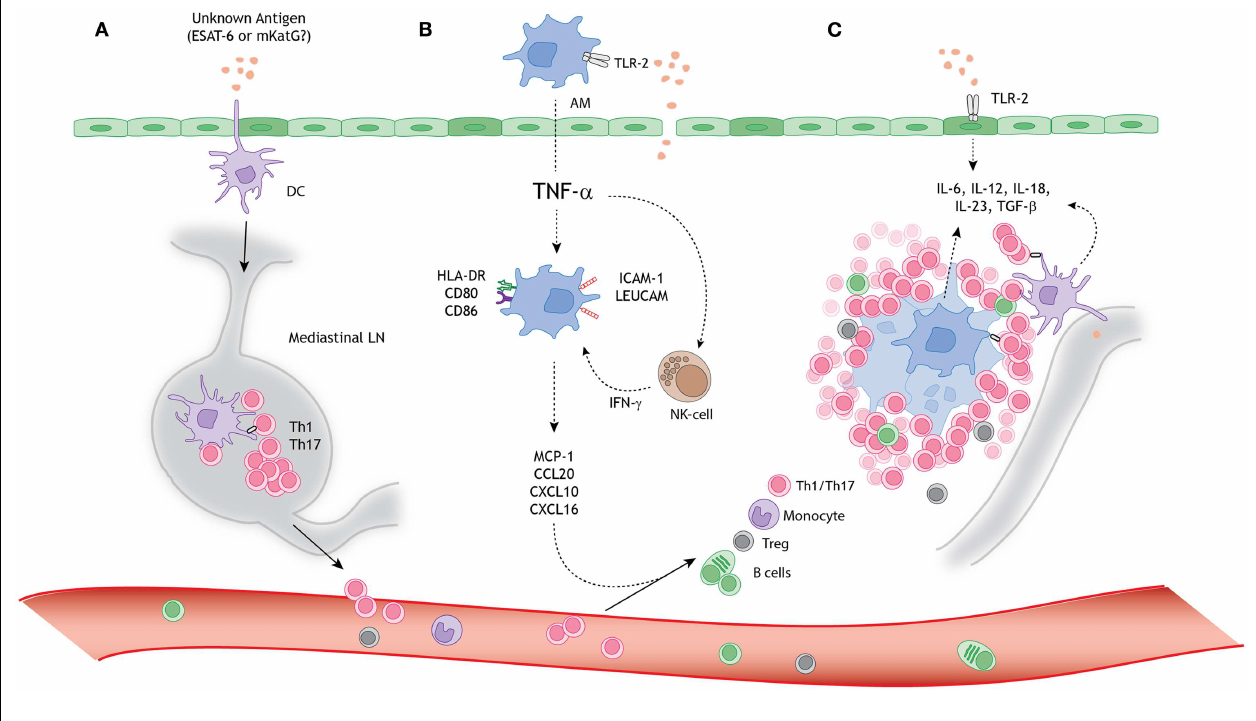
FIGURE 1 |A schematic model for granuloma formation in pulmonary sarcoidosis . An unknown airborne-antigen activates (A) interstitial dendritic cells (DCs), (B) alveolar macrophages (AMs), and (C) alveolar epithelial cells type II (AEC-II) ( dark green ), simultaneously.This process is initiated by toll-like receptor-2 (TLR-2) ligands, possibly Mycobacterium tuberculosis -derived ESAT-6 or mKatG. (A) The interstitial DCs pick up the putative antigen and migrate toward the mediastinal lymph nodes (LNs), where they initiate differentiation and clonal expansion ofT helper (Th)1 and 17 cells. (B) Simultaneously, AMs produce tumor necrosis factor- α (TNF- α ), which initiates upregulation of activation (HLA-DR and CD80/86)